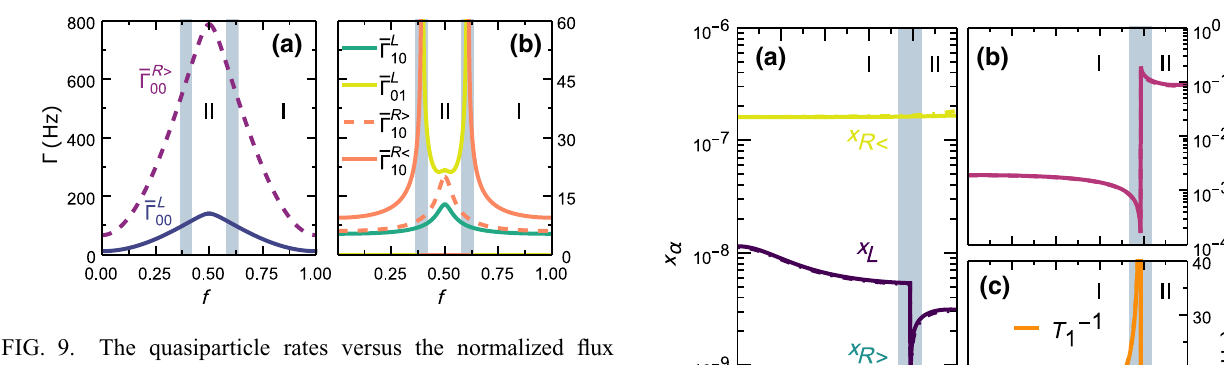
FIG. 9. The quasiparticle rates versus the normalized flux in a split transmon. (a) The parity-switching rates. (b) The relaxation and excitation rates. (For analytical expressions, see Appendix D 1.) The shading denotes the regions where the model cannot be applied. Parameters: (cid:2) L / h = 52 GHz, (cid:2) R / h = 48 GHz, ω 10 ( 0 )/( 2 π) = 7 GHz, g (cid:17) 10 47 J − 1 m − 3 , V L = V R = 940 μ m 3 , and T qp = 20 mK.